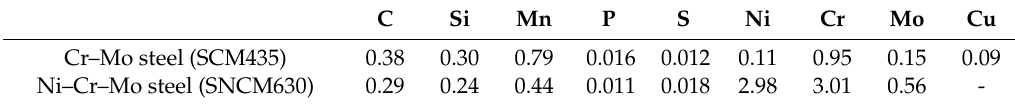
Table 1. Chemical composition of Cr–Mo steel (SCM435) and SNCM 630 (Ni–Cr–Mo steel). (mass%).